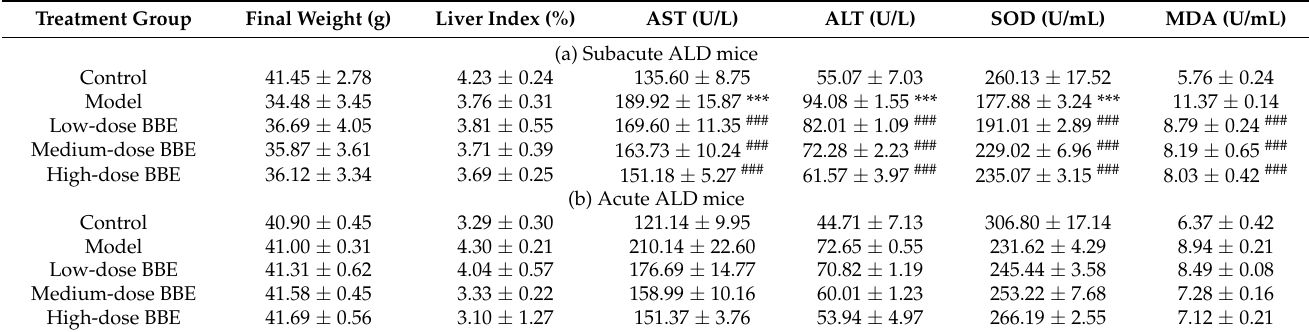
Table 3. Effect of BBE on the activity of biochemical